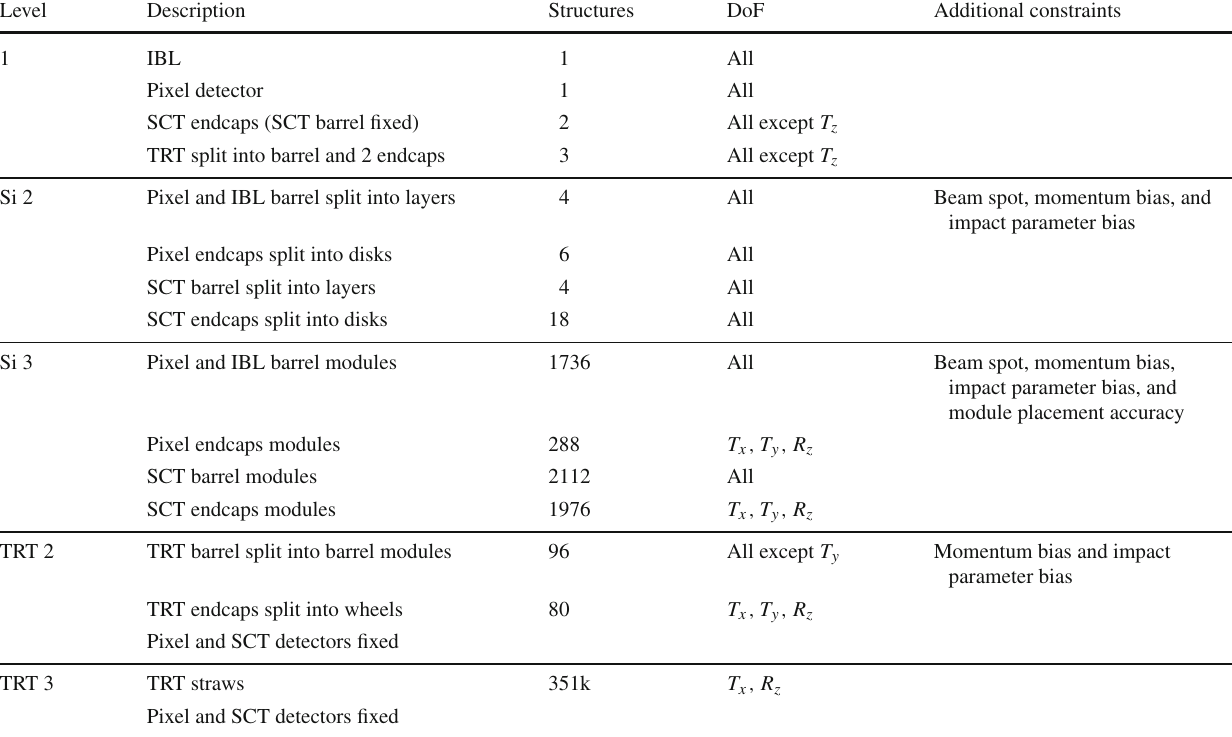
Table 2 Typical alignment configurations used throughout Run 2 data taking to derive baseline alignment constants. Translational degrees of freedom(DoF)aredenotedbya T ,rotationalonesbyan R .Asshownin